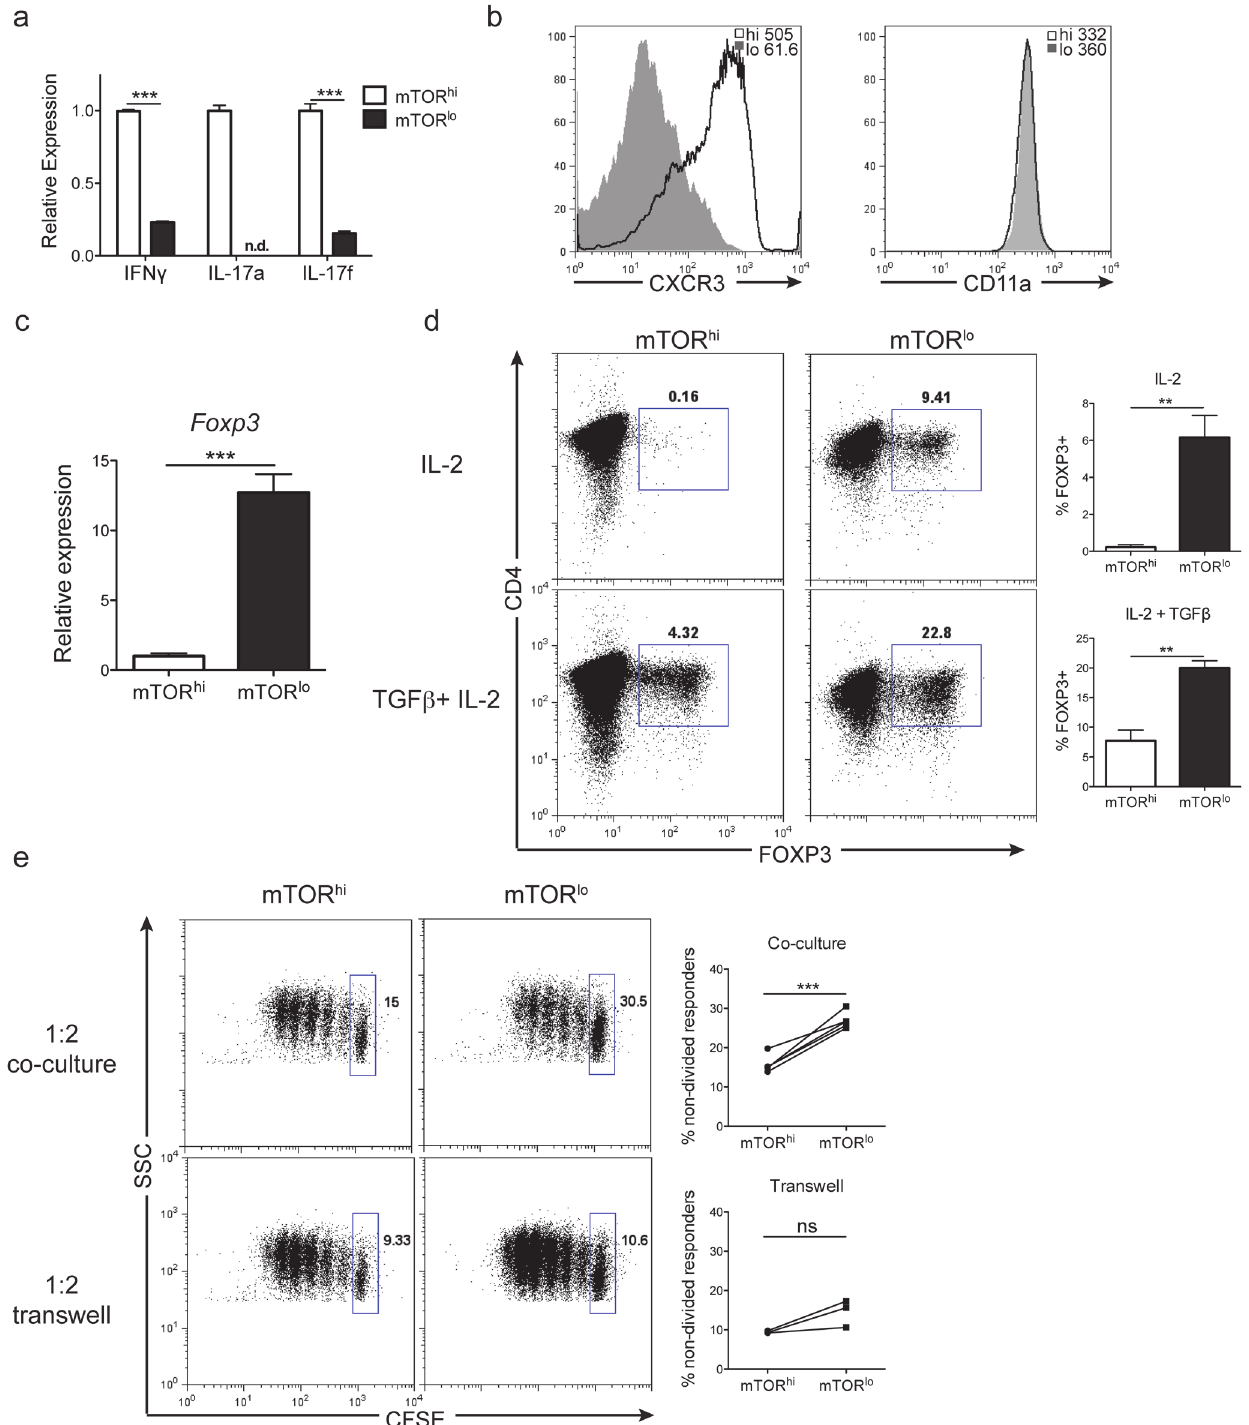
Fig 5. Cell size can be used to isolate recently stimulated CD4+ T cell populations with distinct immunological fates. a) Relative expression of IFN-gamma, IL-17a and IL-17f mRNA transcripts were determined from mTOR hi and mTOR lo populations immediately after sorting stimulated 5c.c7 Rag – / — splenocytes. Error bars show ± S.D. from 3 independent experiments, and mTOR hi values were set to 1. b-d ) Sorted populations of cells were cultured in media supplemented with IL-2 for 3 days prior to assessment. b ) Expression of chemokine receptor, CXCR3, and LFA-1 subunit CD11a was determined by flow cytometry. MFI per population is shown at the top of each FACs plot. c ) Relative expression of Foxp3 mRNA transcript ± S.D. was determined from the mTOR lo population compared to the mTOR hi cells. The graph was generated from 3 independent experiments, and mTOR hi values were